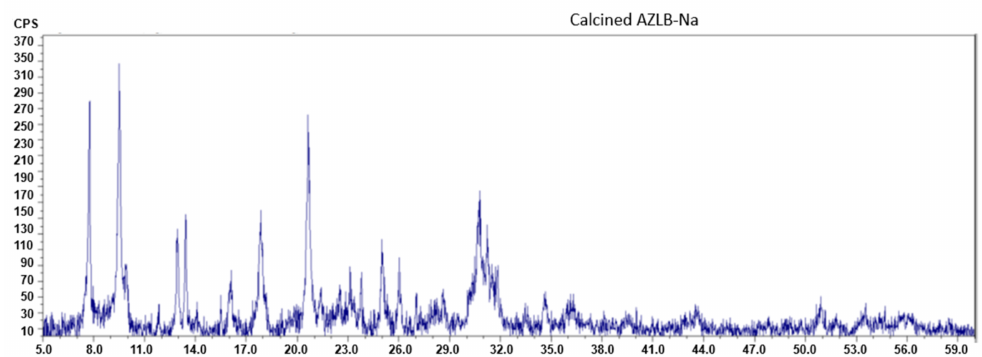
Figure 2. The XRD pattern of calcined